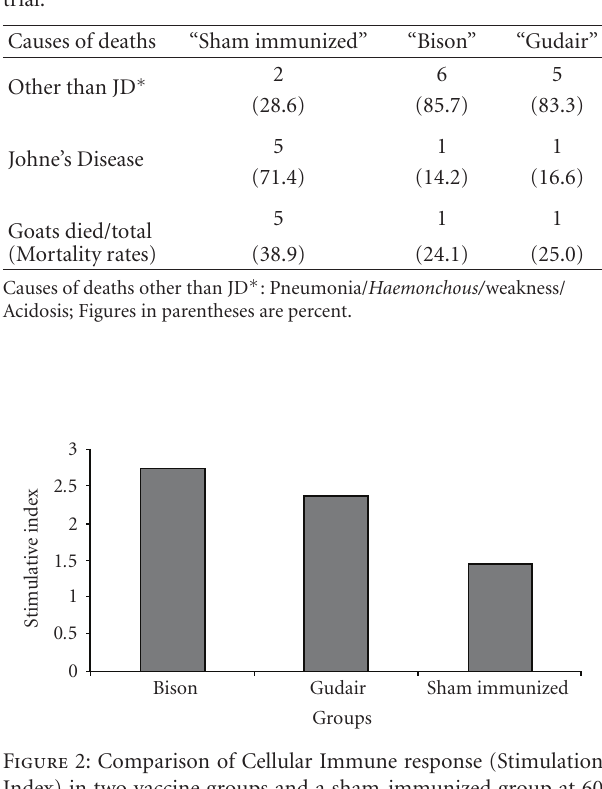
Table 2: Mortality rates and causes of deaths during vaccination trial.